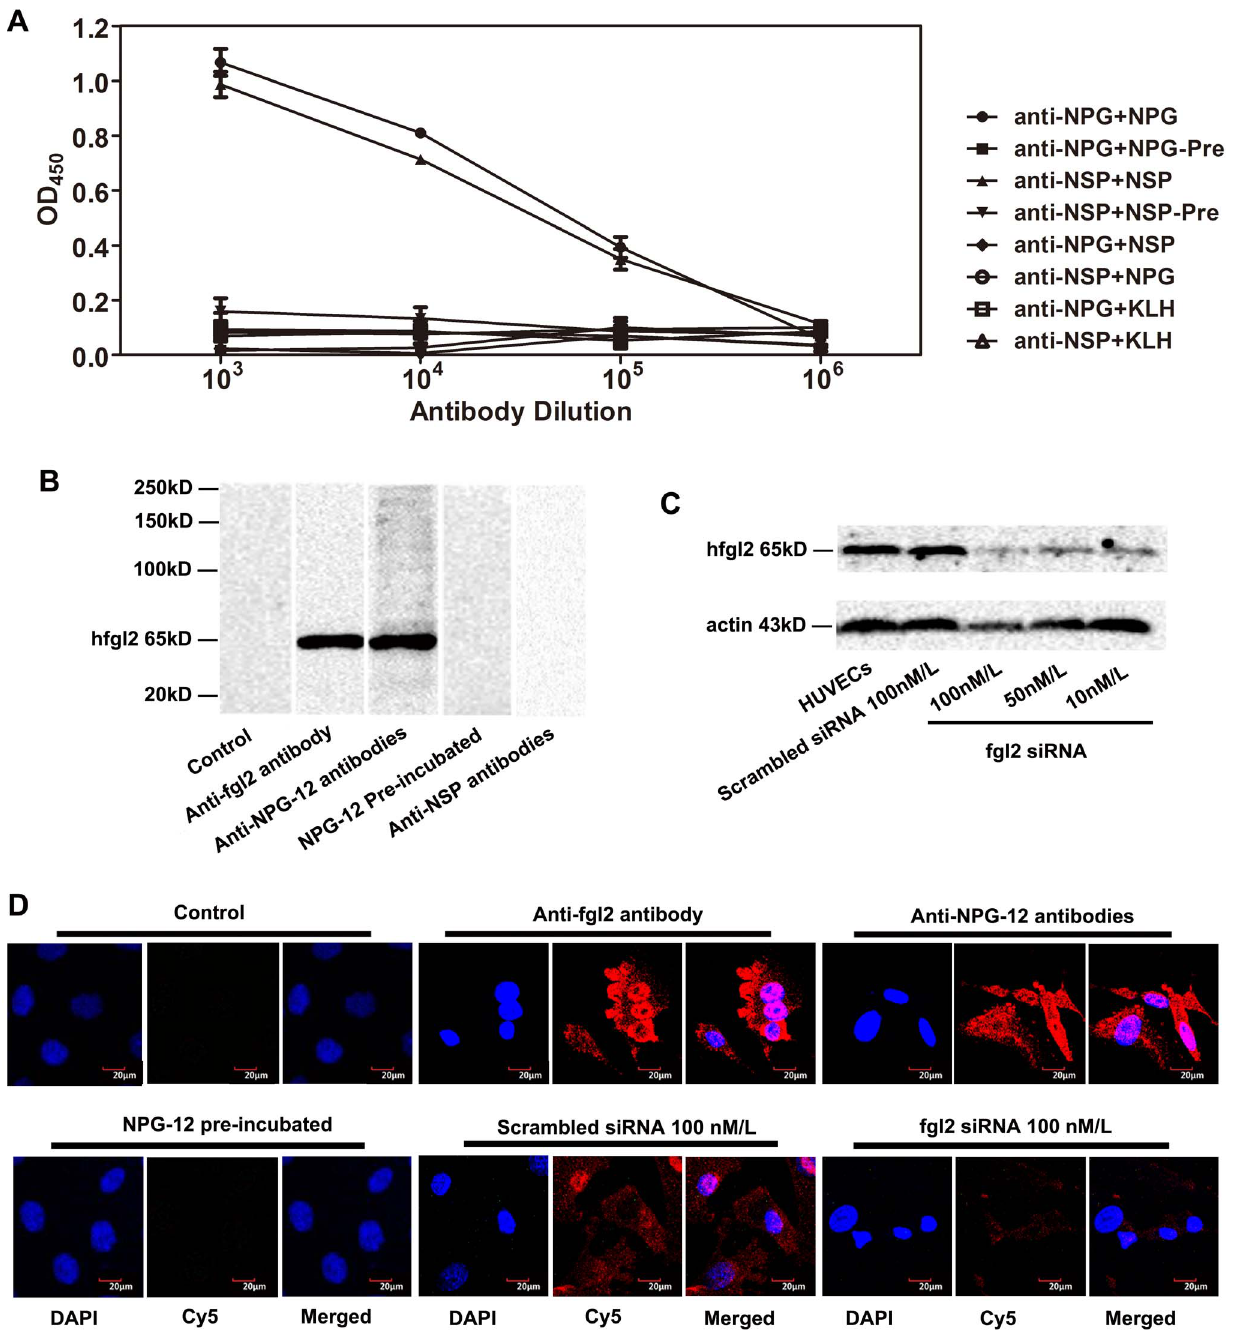
Figure 3. Specificity of anti-NPG-12 antibodies. (A) Peptides were precoated on ELISA plates, and probed with purified antibodies. Anti-NPG-12 antibodies only recognized NPG-12 and anti-NSP antibodies only recognized NSP. The values in the graph are the means 6 S.E.M (n=3). (B) Anti- NPG-12 antibodies specifically recognized hfgl2 expressed in HUVECs exposed to TNF- a for 24 h, as evidenced by western blotting. Anti-fgl2 antibody (2 m g/ml) and anti-NPG-12 antibodies (1 m g/ml) specifically recognized a 65-kD protein, and there was no detection in the control (no primary antibody), NPG-12-pre-incubated, or anti-NSP antibody groups. (C) WB of HUVECs lysates 72 h after siRNA transfection, gray-scale value or fgl2 expression was reduced by siRNA transfection dependent on fgl2-siRNA concentrations. Actin served as a loading control. (D) Representative HUVEC sections illustrate that the anti-NPG-12 antibodies specifically recognized hfgl2 on HUVECs exposed to TNF- a for 24 h or siRNA transfected HUVECs, as evidenced by immunostaining. The nuclei were stained with DAPI (blue), and the plasma membranes were stained with Cy5-labelled (red) secondary antibody in the anti-fgl2-antibody-treated (5 m g/ml) and anti-NPG-12-antibodies-treated (5 m g/ml) groups. The fluorescence intensity obviously decreased in fgl2-siRNA transfection group incubation with anti-NPG-12 and Cy5-labelled antibodies. No fluorescence was detected in the control group (no primary antibody) or the NPG-12-pre-incubated group treated with anti-NPG-12 antibodies. Scale bar =20 m m.